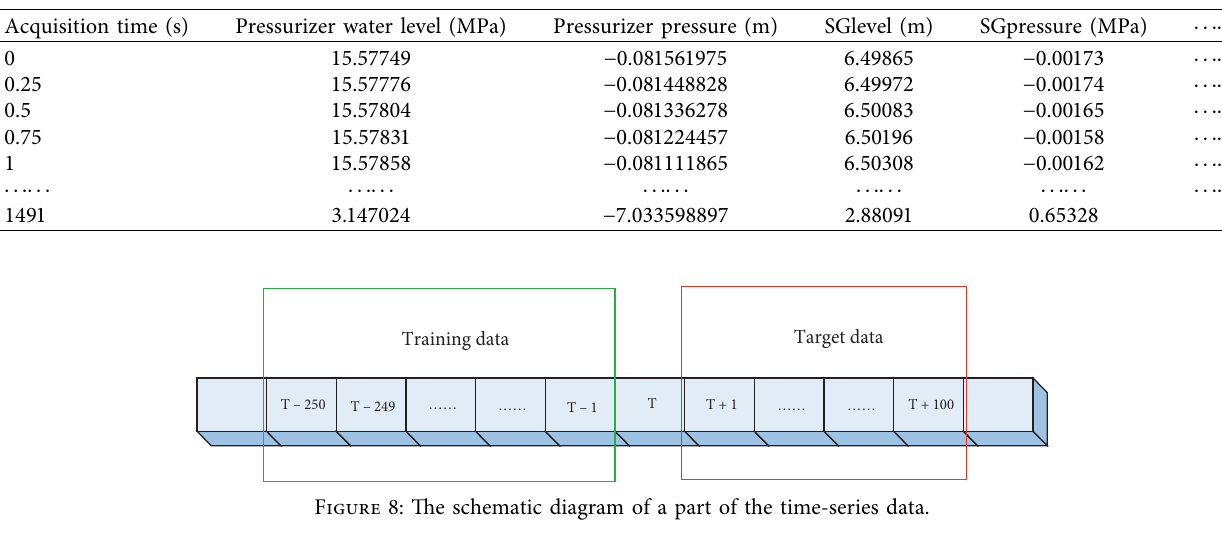
Table 3: Some of the key parameters of a nuclear power plant in the case of the LOCA accident.